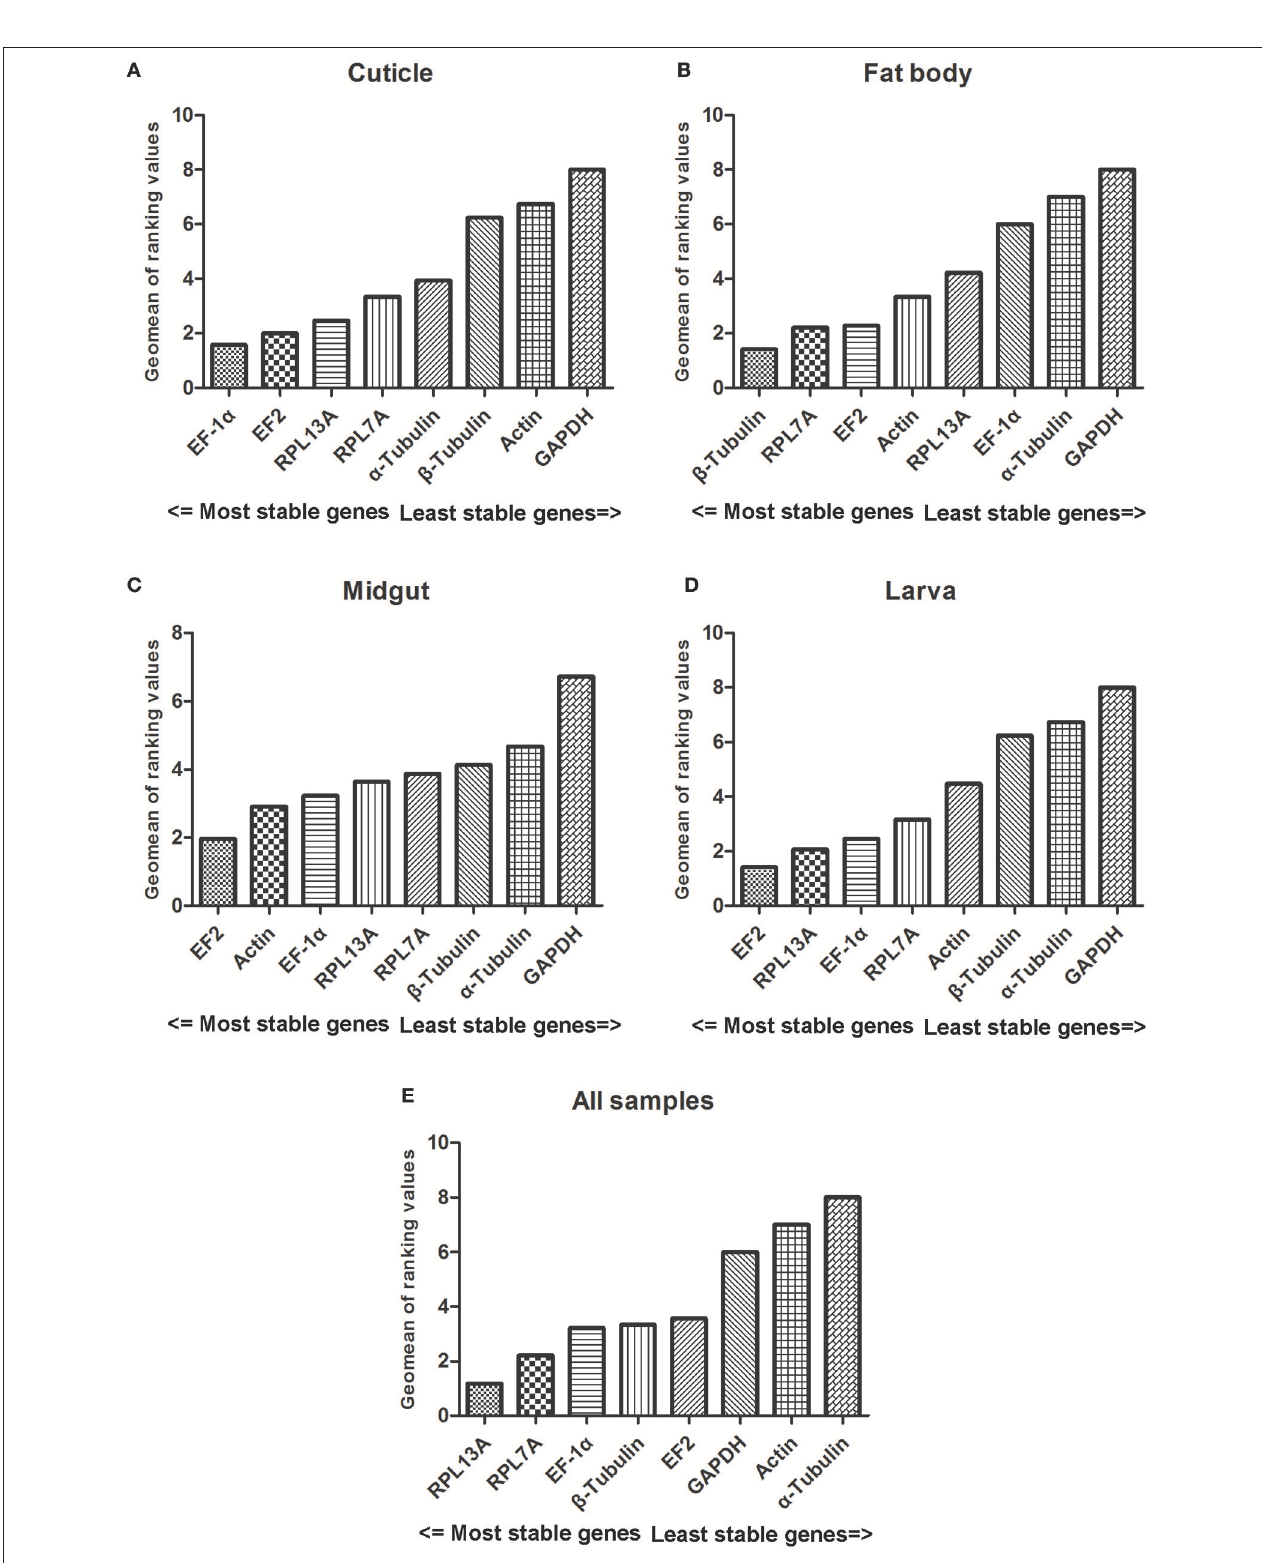
FIGURE 5 | Stability values of the candidate reference genes in different experiment sets generated by RefFinder algorithm. Abbreviations were showed as in Figure 1 . Panels (A–E) were represented as the stability validation results of reference genes expression in cuticle, fat body, midgut, larva, and all samples.